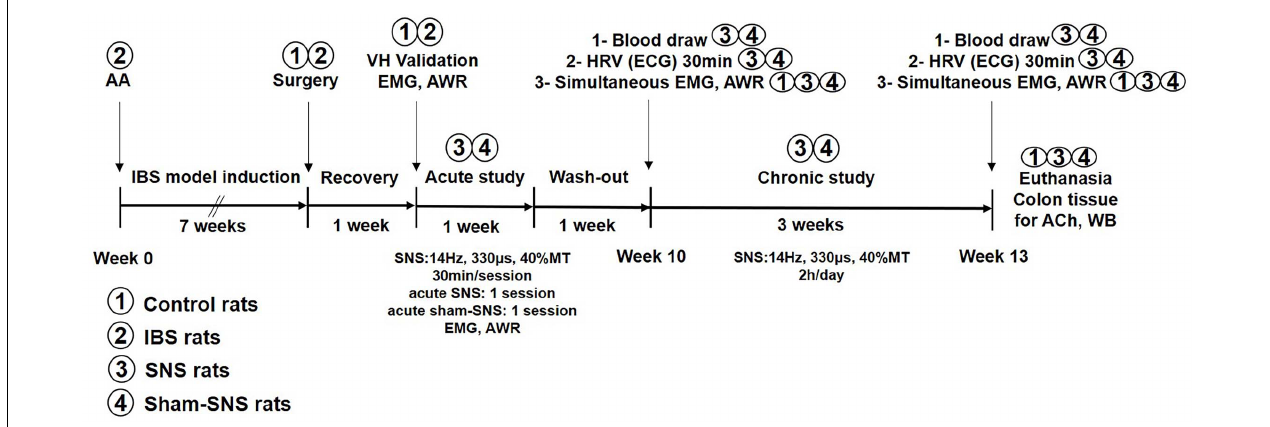
FIGURE 1 | Experimental design and the effects of acute and chronic SNS and sham-SNS on visceral hypersensitivity. EMG and AWR were assessed using colorectal distention test in hypersensitive and control (normal rats). Animal groups are presented by